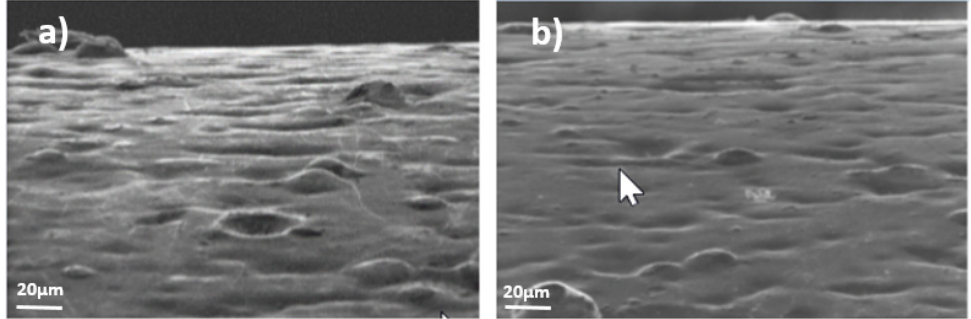
Figure 13. Example of surface evolution in sample 5 under compressive stresses (F); ( a ) month 1, ( b ) month 8.